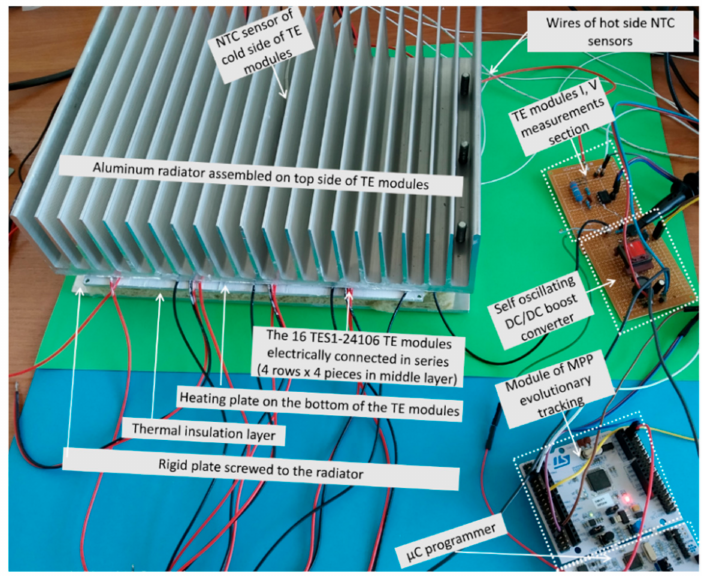
Figure 8. The laboratory test station of TE panel with passive